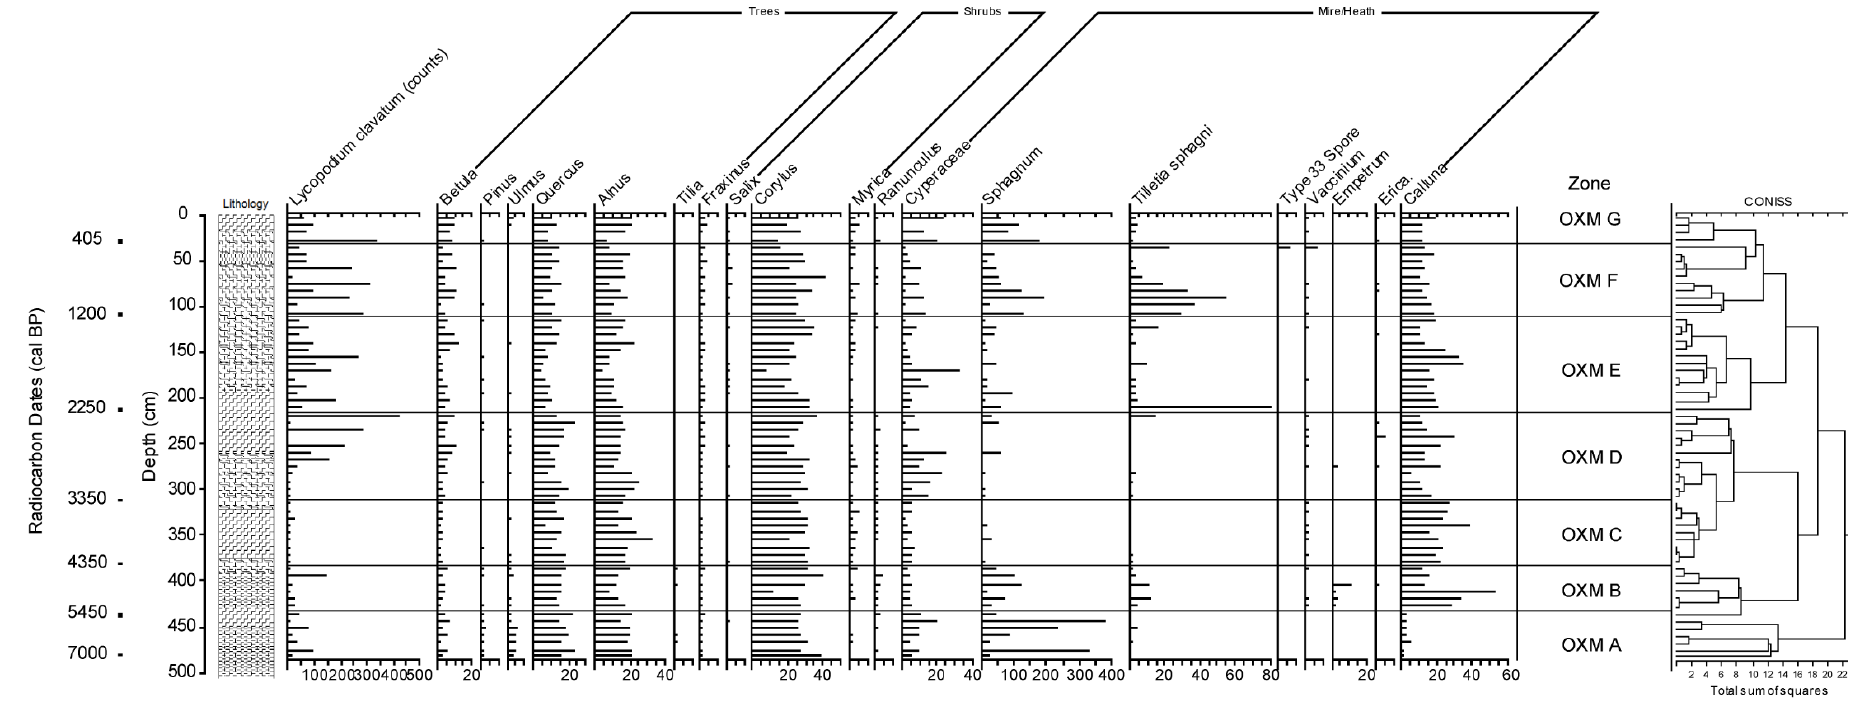
Figure 2 (part). Pollen percentages using depth (cm), radiocarbon ages (cal. BP), lithology (Troels-Smith 1955), number of charcoal fragments counted ( per 500 counted terrestrial pollen grains), and number of SCPs counted ( per 500 counted terrestrial pollen grains). Continued